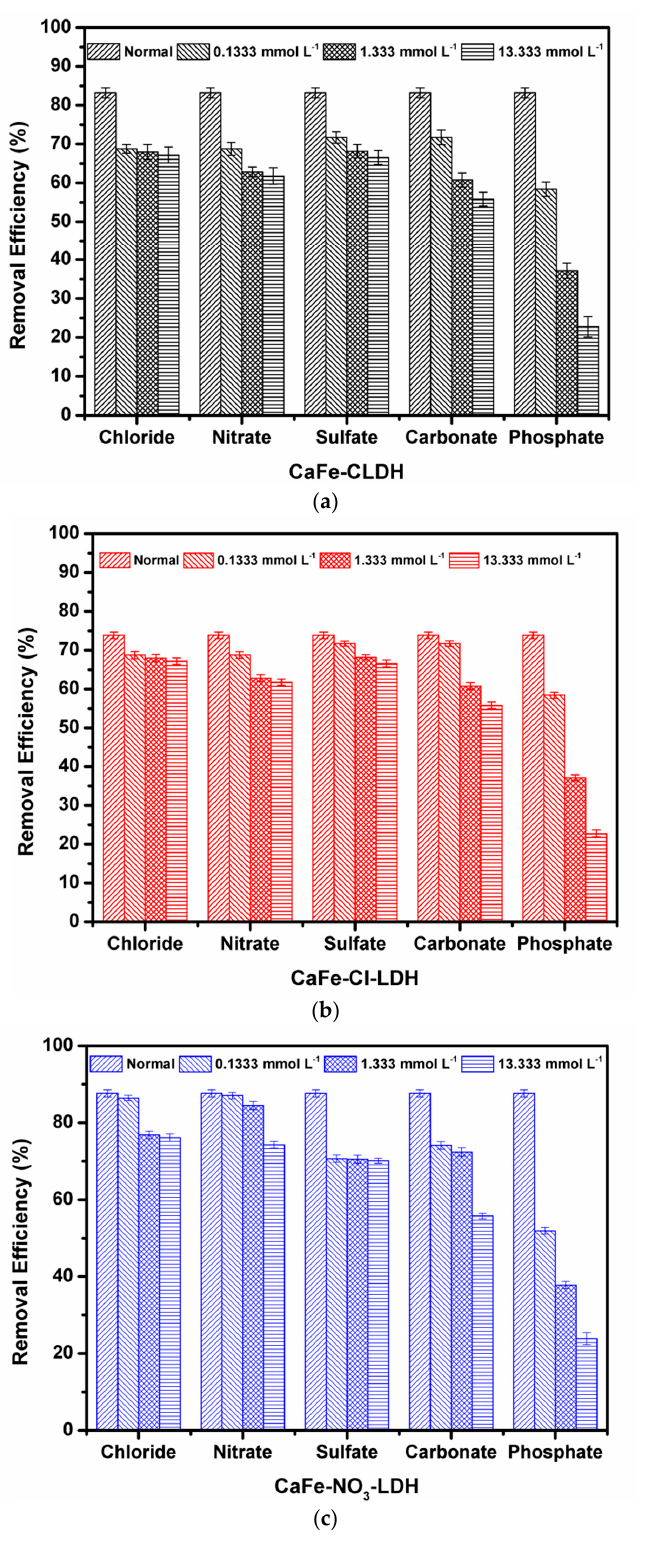
Figure 6. Effect of coexisting anions on arsenic removal by materials in water: ( a ) CaFe-CLDH; ( b ) CaFe-Cl-LDH; ( c ) CaFe-NO 3 -LDH (Experimental condition: initial concentration of arsenate was 5 mg · L − 1 , materials dosage = 0.2 g · L − 1 , initial pH =